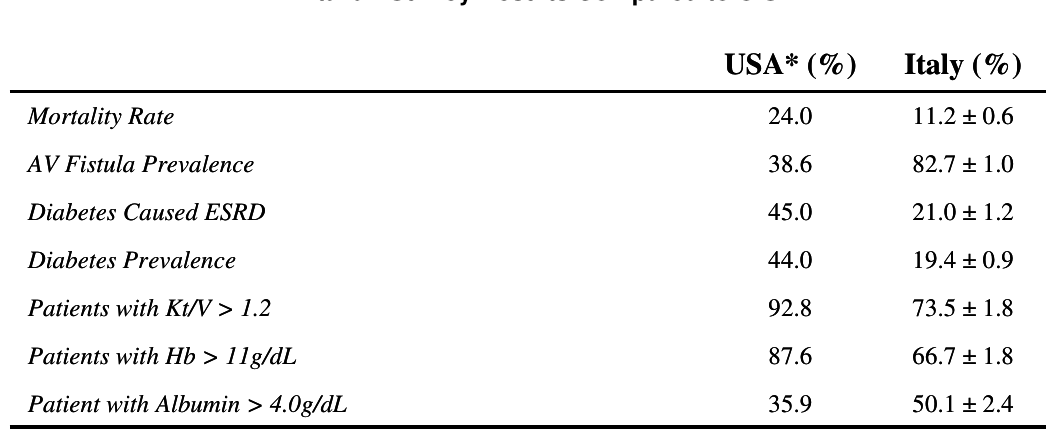
Italian Survey Results Compared to